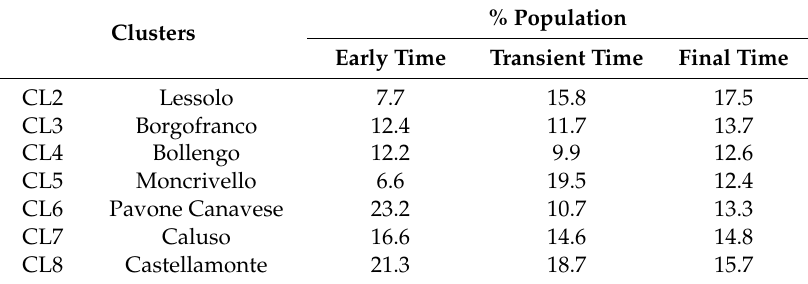
Table 8. Percentage distribution of the population dynamics in the MAI landscape as resulting from the integrated model (excluding Ivrea from the clusters